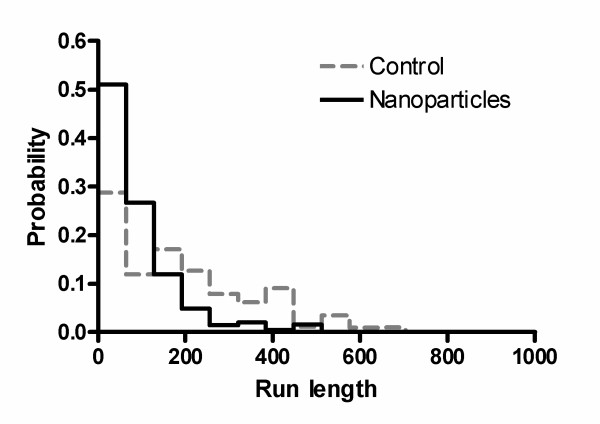
Run length histograms of the black (background) runs of a nanoparticle image an a control image. The higher complexity of the structure in the presence of nanoparticles leads to shorter runs. Consequently, the control histogram is broader and shifted towards longer runs.